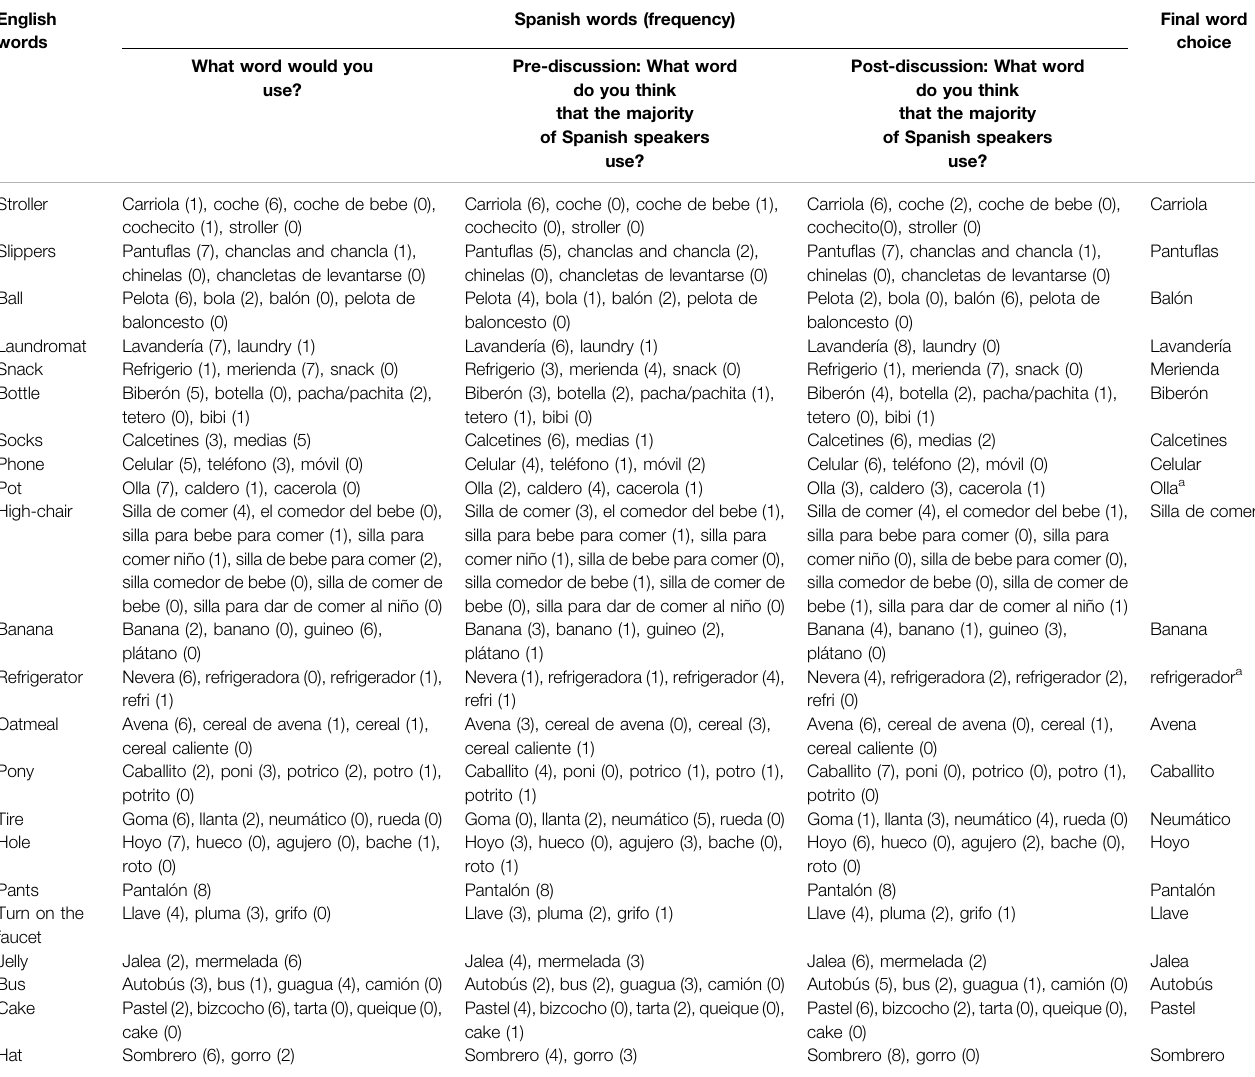
TABLE 4 | Results from objects portion of focus